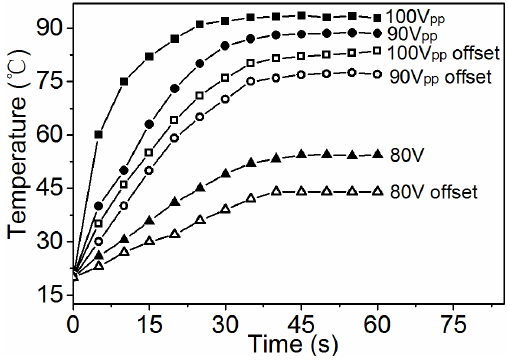
Figure 15. Surface temperature change vs. time at various voltages.